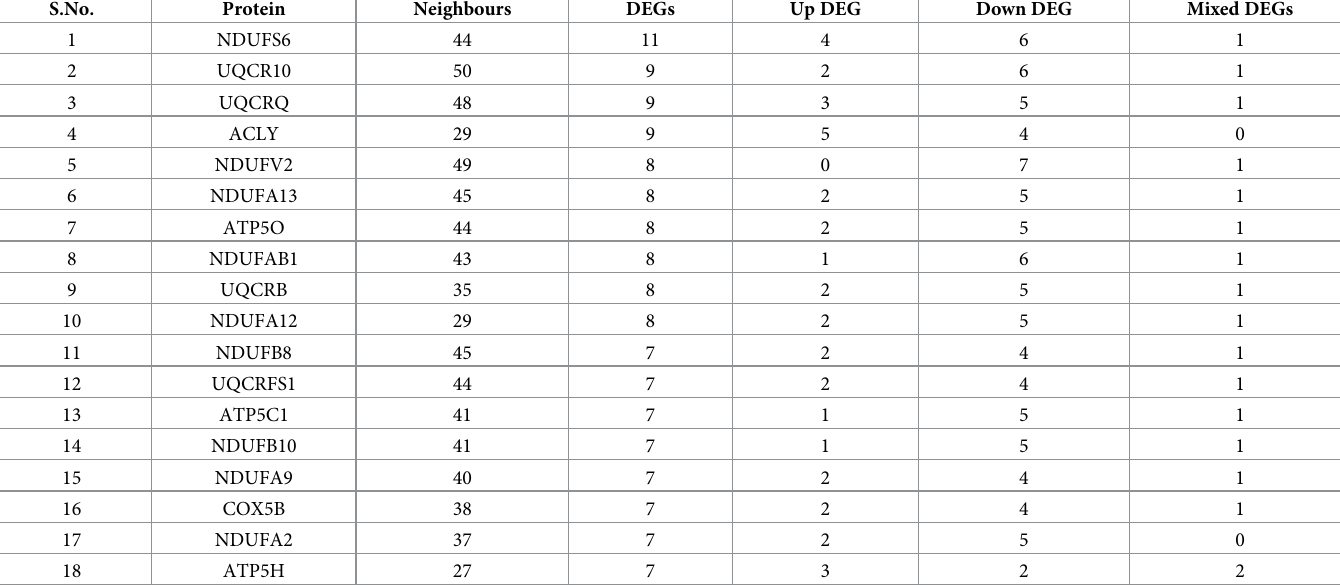
Table 5. The important hubs with a high number of neighbours and DEGs among them.